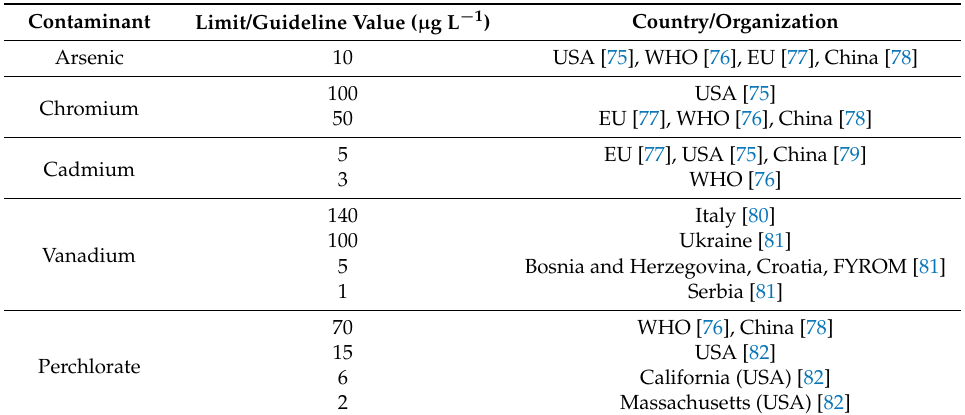
Table 1. Standards in drinking water prescribed by national/regional regulations and international guidelines for the contaminants considered in the